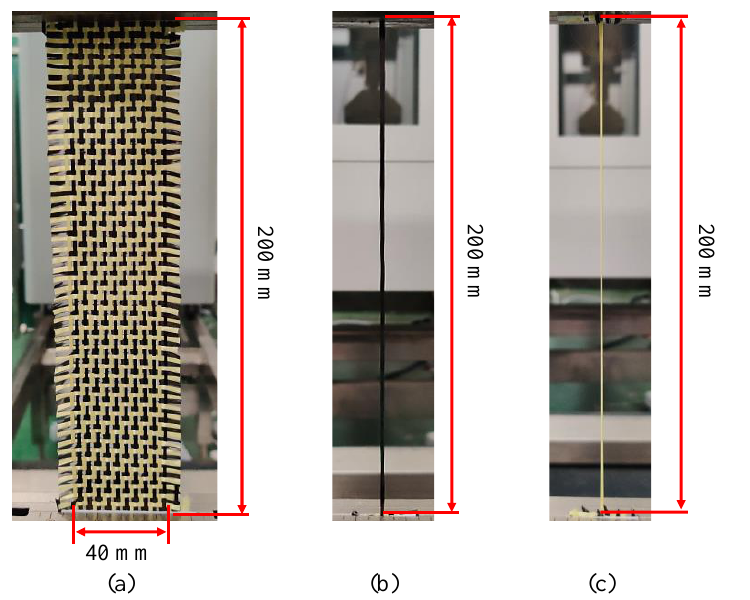
Figure 2. Tested specimen in the tensile test: ( a ) hybrid woven reinforcement; ( b ) carbon yarn; ( c ) Kevlar yarn.